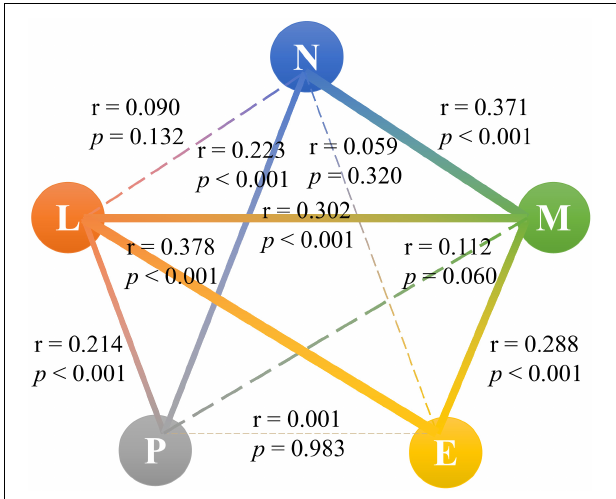
FIGURE 2 | Correlation between neutrophil, lymphocyte, platelet, eosinophil, and monocyte. N, neutrophil; L, lymphocyte; P, platelet; E, eosinophil; M, monocyte.